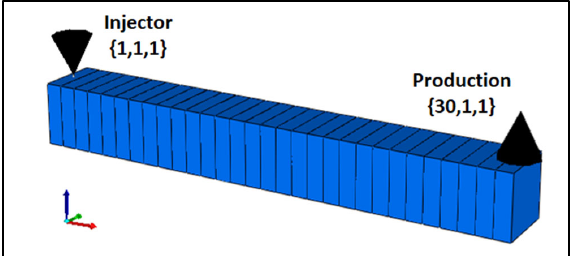
Figure 1. Simulation grid design with Injector well and Production well.